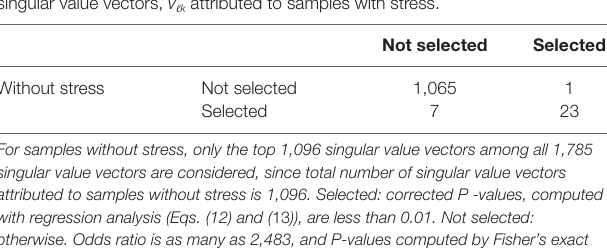
,attributed to ℓ j